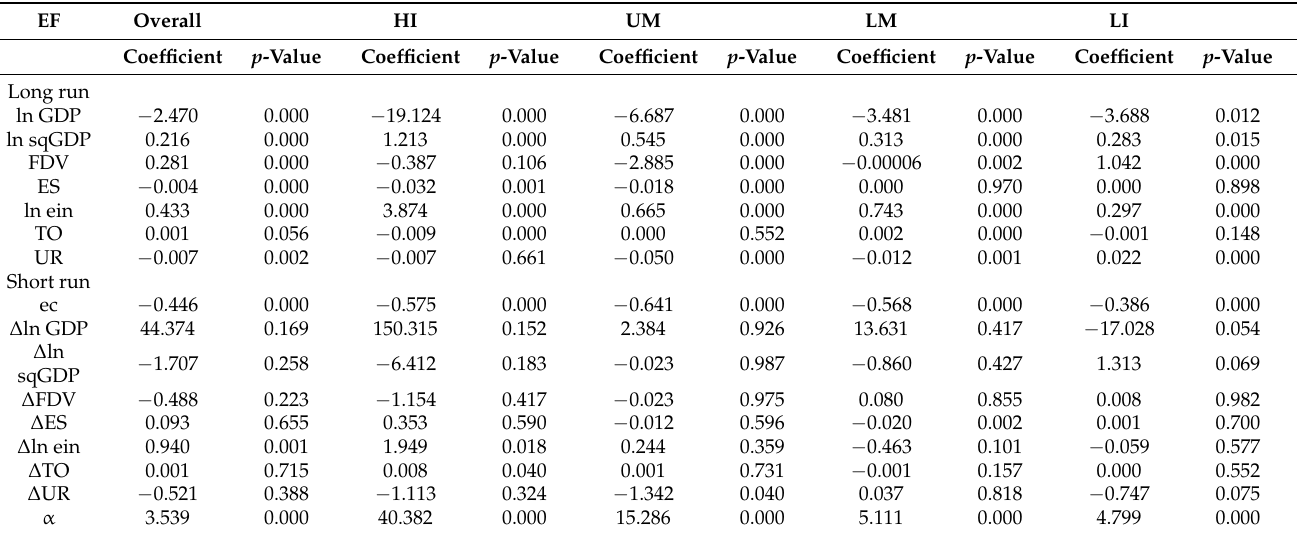
Table 6. (Model 1): The long and short-run relation between EF and ln GDP, ln GDP square, FDV, ES ln ein, TO, UR.